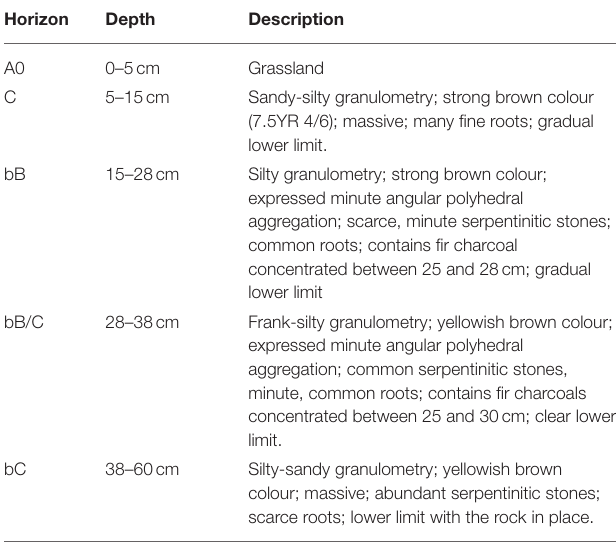
TABLE 3 | Description of the soil horizons from the selected profile (T2) in Ottomano (2002).